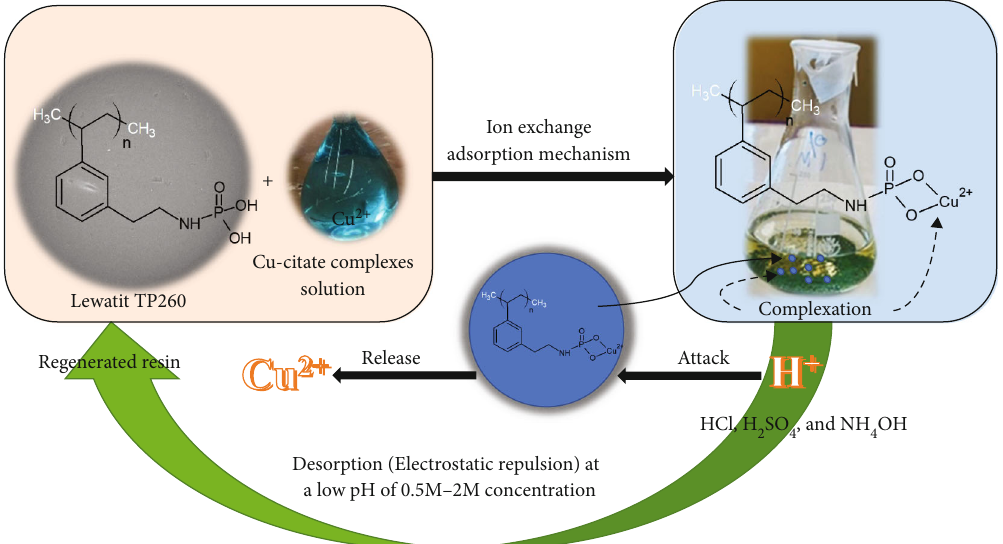
Figure 7: Possible schematic mechanism for adsorption and desorption of copper (II) ions using Lewatit TP260 chelating resin as an